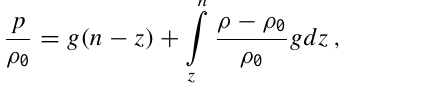
Table 1. Heat budget components estimated with different formu-